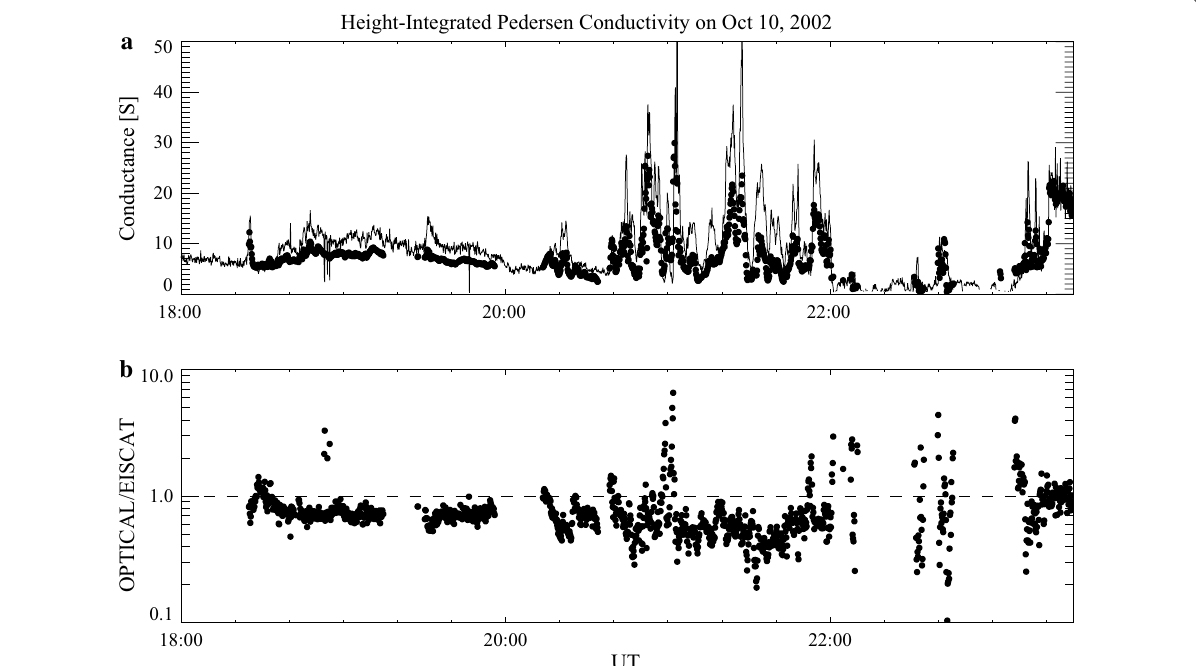
Fig. 3 Comparison of Pedersen conductivities for October 10, 2002; a temporal variations of the height-integrated Pedersen conductivities derived with the EISCAT UHF radar ( solid line ) and the photometer observations ( closed circle ) between 18:00 and 23:30 UT on October 10, 2002. b Temporal variation of the ratio of the height-integrated Pedersen conductivity from the photometric value to the EISCAT radar